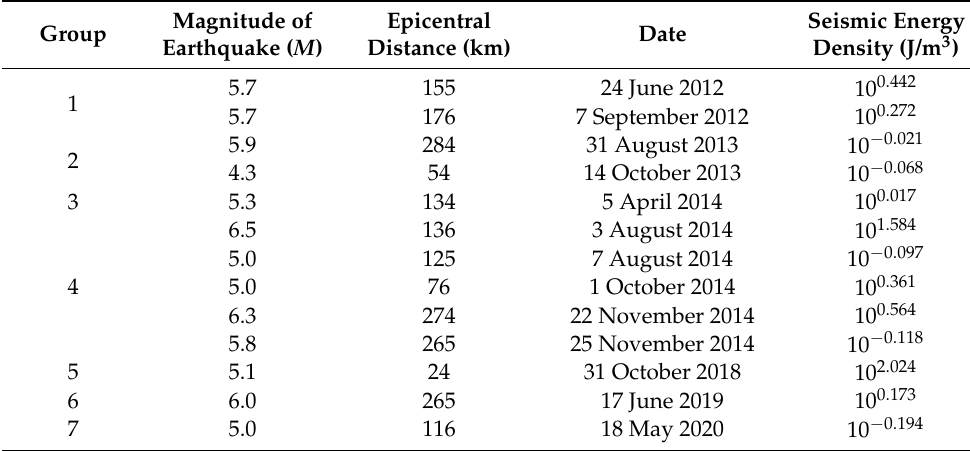
Table 1. The specific information of selected earthquake events. Magnitude of Group Earthquake ( M